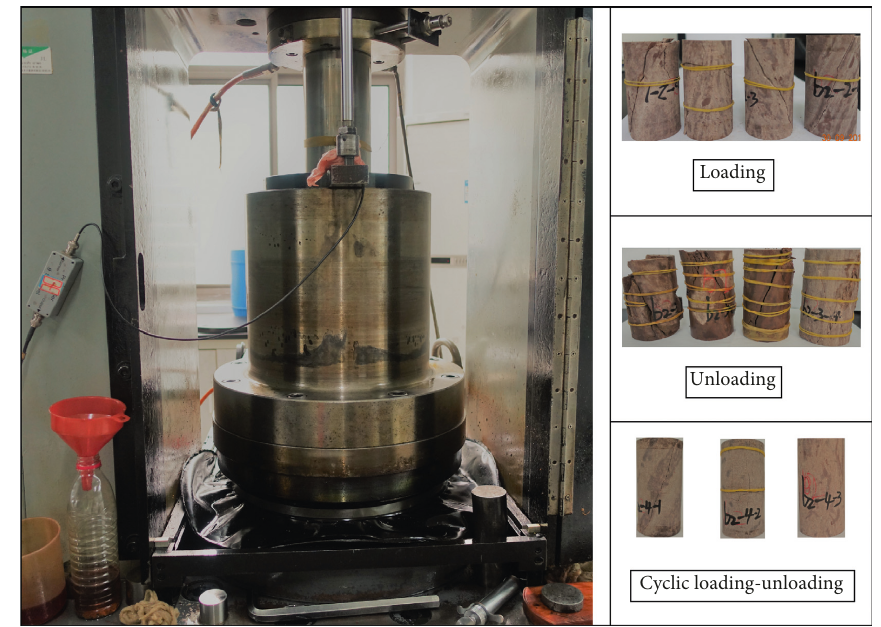
Figure 3: The test instrument.